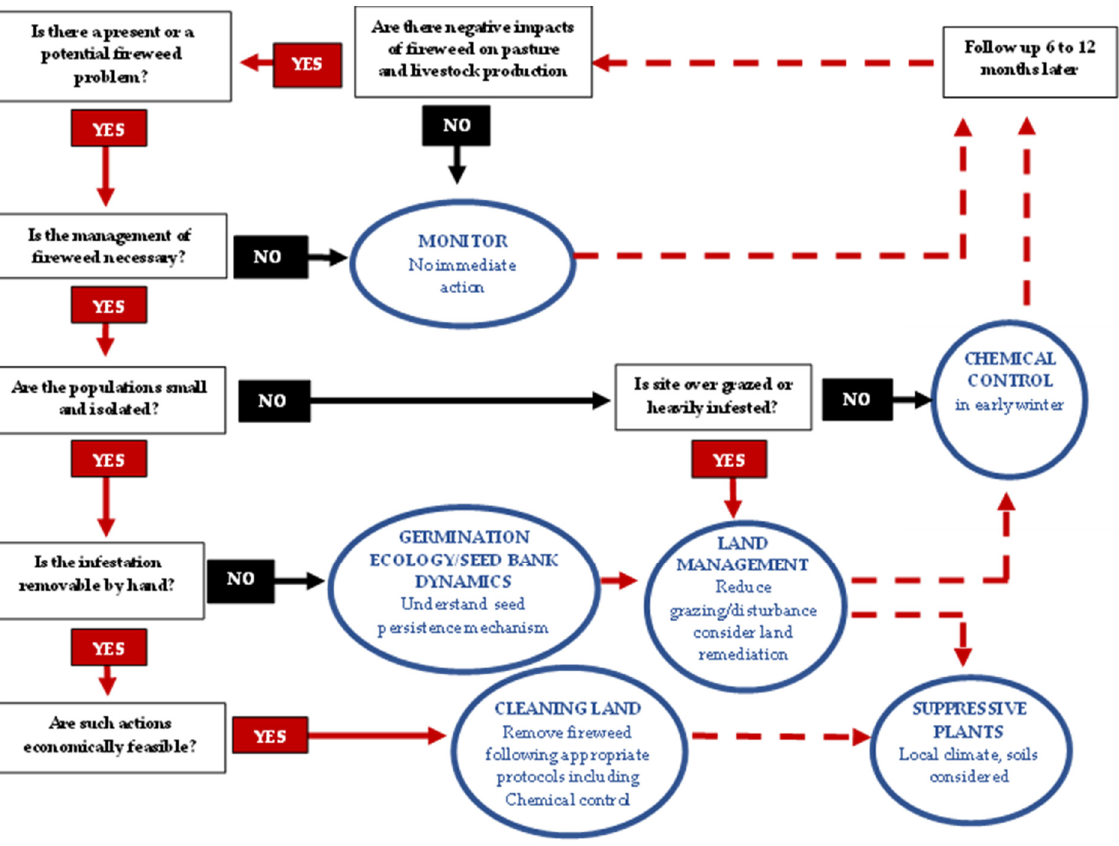
Figure 2. Conceptual decision diagram for proposing approaches to the integrated man-agement of fireweed incorporating managerial, chemical, and manual control.